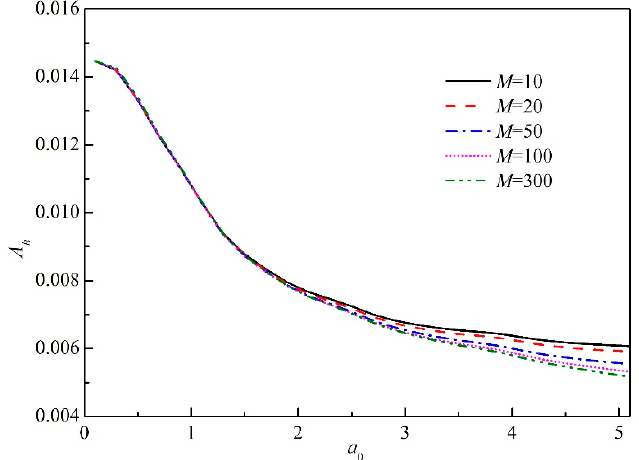
Figure 9. Dynamic response factor of embedded foundation under different poroelastic material properties.